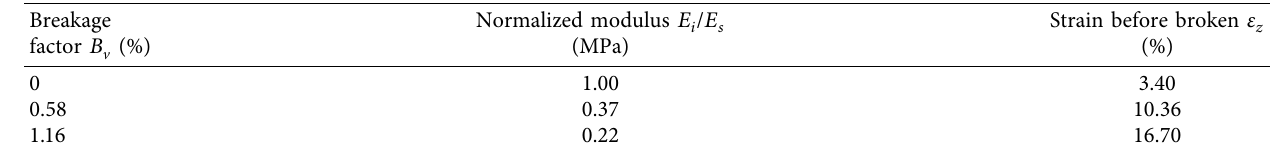
Figure 12: Broken PMMA balls. Table 9: Breakage factor and normalized compressive modulus.